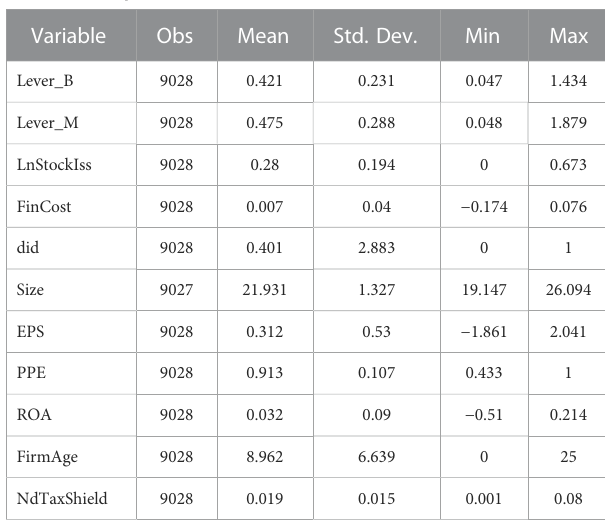
TABLE 2 Descriptive